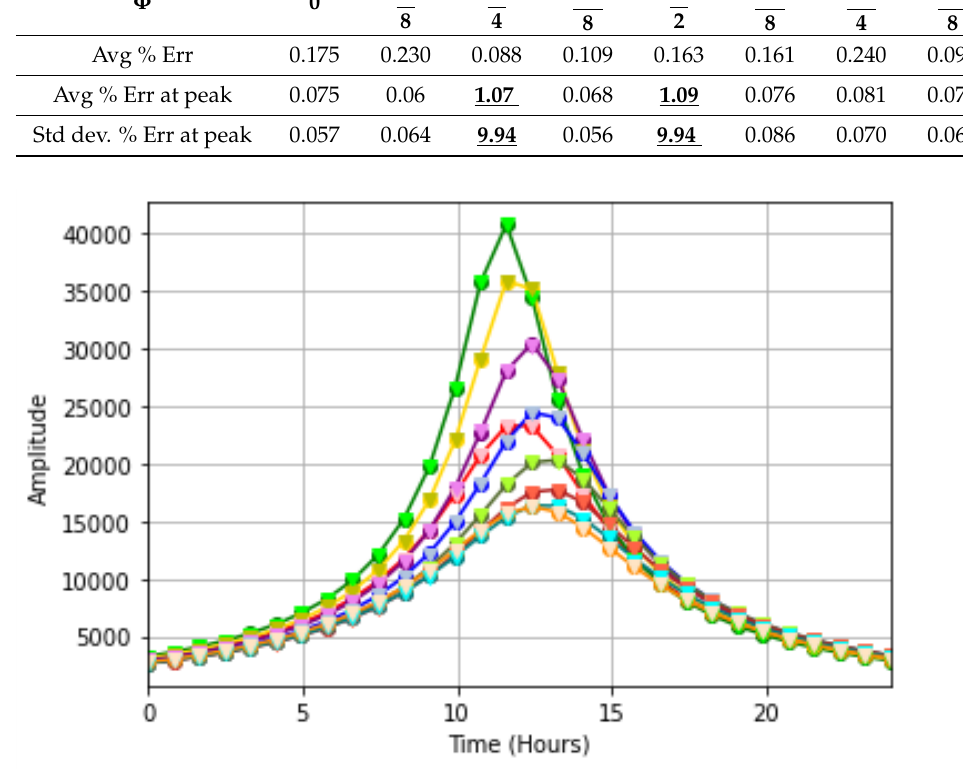
Figure 7. Photometric curves generated by different parallax values, shown with its corresponding CS reconstructed curve for R = 7000 km.